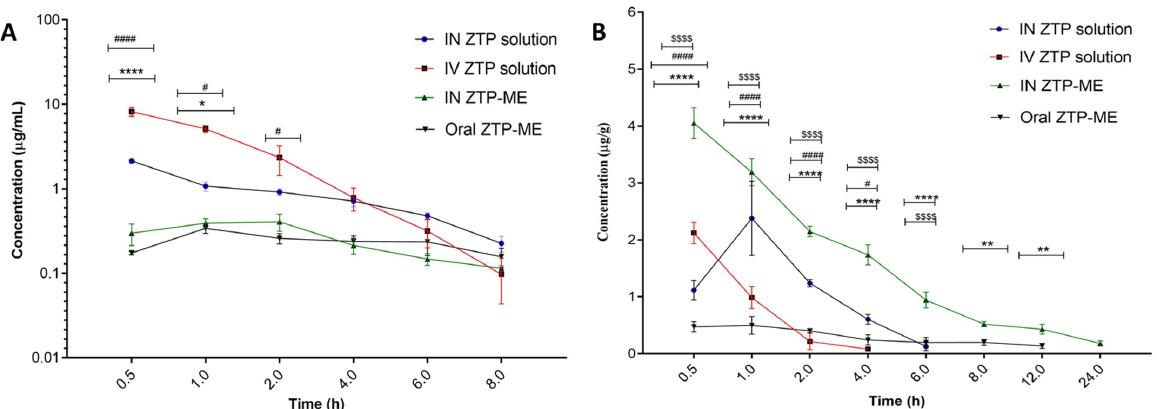
Figure 7. Concentrations of zotepine in ( A ) plasma and ( B ) brain after intranasal and oral administration of ZTP-ME. Data are represented as the mean ± SEM ( n = 3). **** p < 0.0001 IV ZTP solution vs. IN